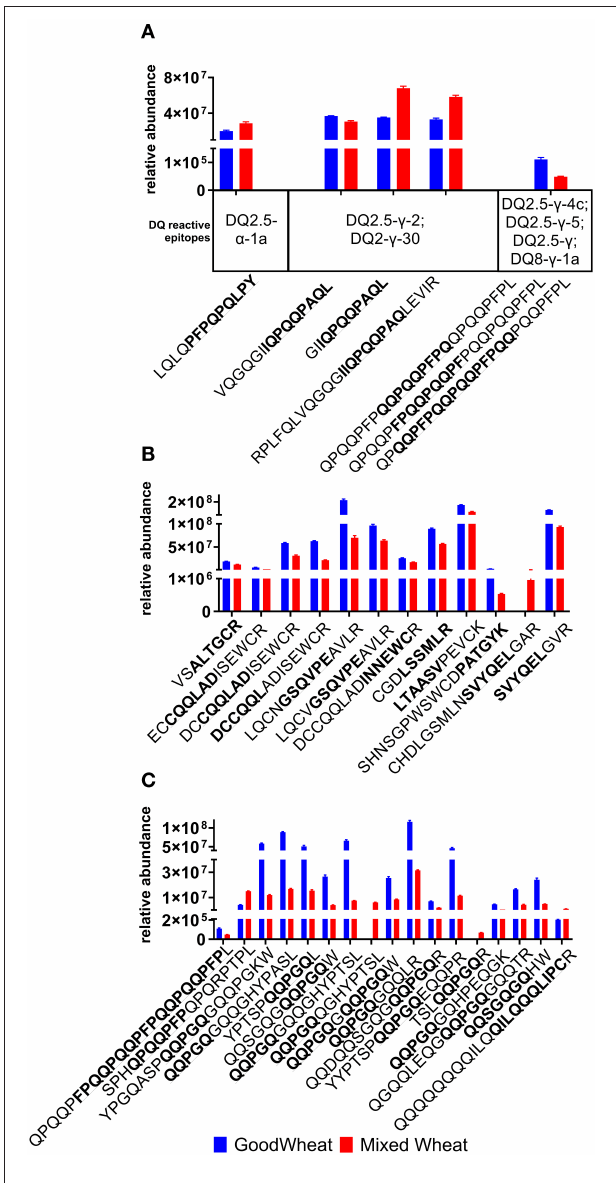
FIGURE 5 | Relative abundance of immune reactive epitopes in peptides quantified in MRM assays, reported as mean and standard error. Epitope sequences are highlighted in bold within the peptide sequence: (A) Coeliac disease HLA-DQ reactive epitopes; (B) Bakers’ asthma; (C) Wheat Allergy plus peptide QQQQQQQQILQQILQQQLIPCR which contains the epitope QILQQQLIPC antigenic for wheat-dependent exercise induced anaphylaxis. When calculating the total, duplicate peptides where multiple epitopes were detected were only counted